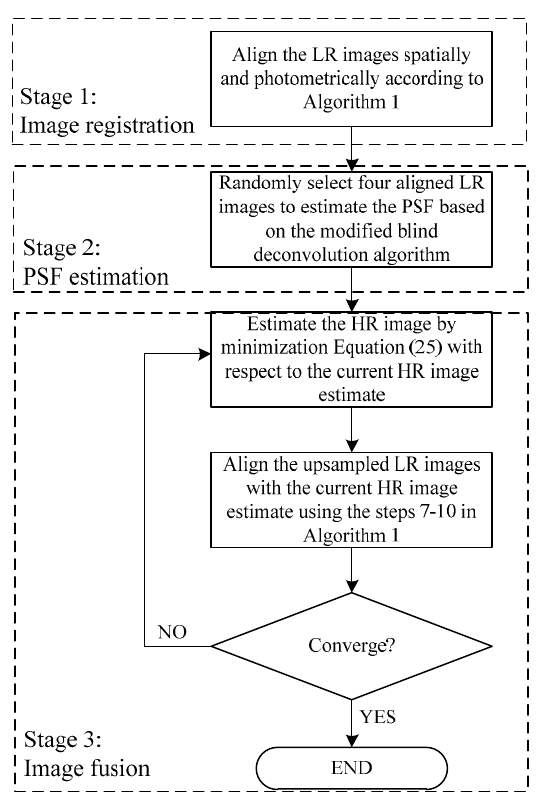
Figure 1. Diagram of the proposed algorithm.